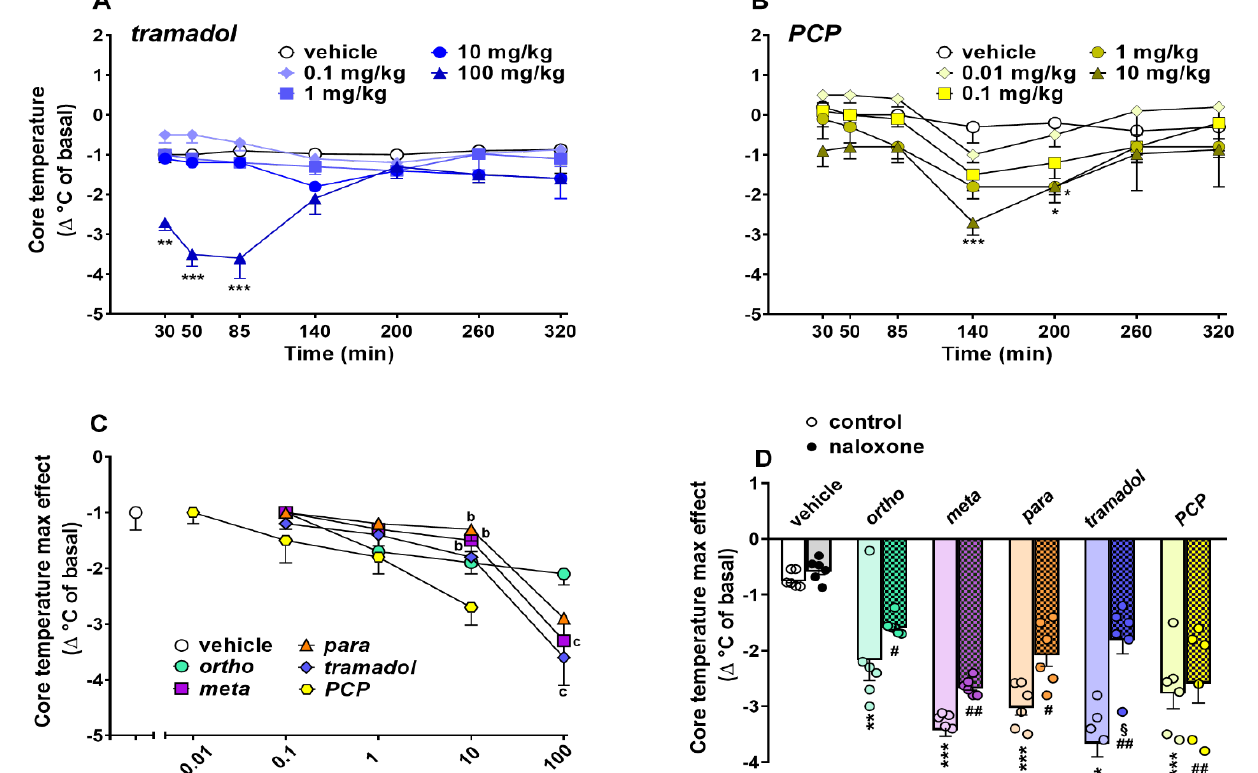
Figure 6. Effects of the systemic administration of tramadol (0.1–100 mg/kg i.p.; ( A )) and PCP (0.01–10 mg/kg i.p.; ( B )) on the mouse core temperature. Comparison of the maximal effect of ortho, meta, para, tramadol (0.1–100 mg/kg) and PCP (0.01–10 mg/kg) observed in 5 h ( C ) 1 . Interaction of the effects of ortho, meta, para, tramadol (100 mg/kg) and PCP (10 mg/kg) with the opioid receptor antagonist naloxone (6 mg/kg, i.p.; ( D )). Data are expressed as the difference between control temperature (before injection) and temperature following drug administration (Δ°C; see material and methods), and represent the mean ± SEM of 6–8 determinations for each treatment. Statistical analysis was performed by two-way ANOVA followed by the Bonferroni’s test for multiple comparisons for the dose–response curve of each compound at different times ( A , B ), and for the antagonist studies ( D ), while the statistical analysis of ( C ) was performed with one-way ANOVA followed by Bonferroni test for multiple comparisons. * p < 0.05, ** p < 0.01, *** p < 0.001 versus vehicle; b p < 0.05 versus PCP; c p < 0.05 versus ortho; # p < 0.05, ## p < 0.01 versus naloxone; § p < 0.05 versus without naloxone. 1 ortho, meta and para data are elaborated from [5].